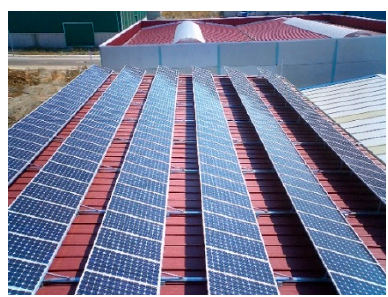
Figure 2. System 1 facility located in the city of Palencia. Fixed roof panels.